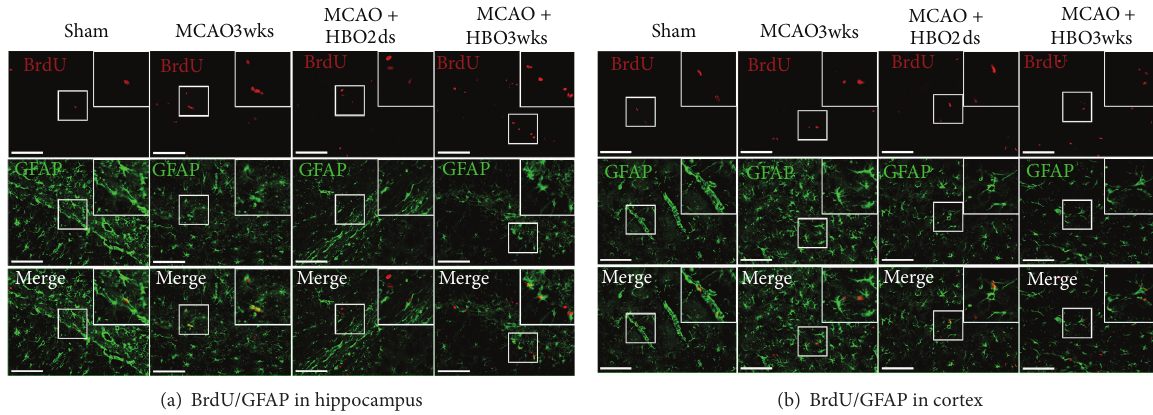
Figure 5: Long course HBO increased gliosis. ((a) and (b)) Demonstration of double staining showed that there were significantly more newly forming or reactive glia in the ischemic boundary area (dentate gyrus (a) and cortex (b)) of HBO3wks rats than HBO2ds rats. The intensity of co-staining with BrdU and Neu-N was more prominent in HBO3wks